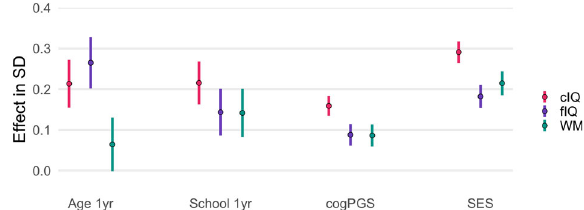
Fig. 2 Main effects for cognition. Independent effects of 1 year of age, 1 year of schooling, cogPGS, and SES from mixed-effects models predicting c IQ, f IQ, and WM (Eq. 2). All results are signi fi cant for predicting their respective cognitive domain (Supplementary Tables 3 – 5). Bars re fl ect 95% frequentist con fi dence